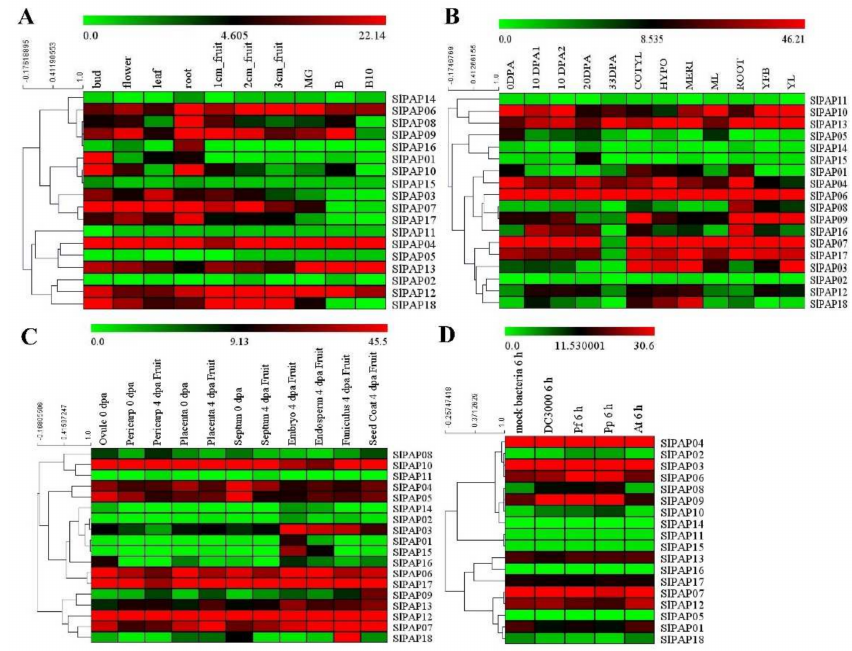
Figure 5. Expression profiles of SlPAP genes on RNA-seq in different tomato tissues and species. Heat maps are presented in green/black/red/colors that represent low/medium/high expression,